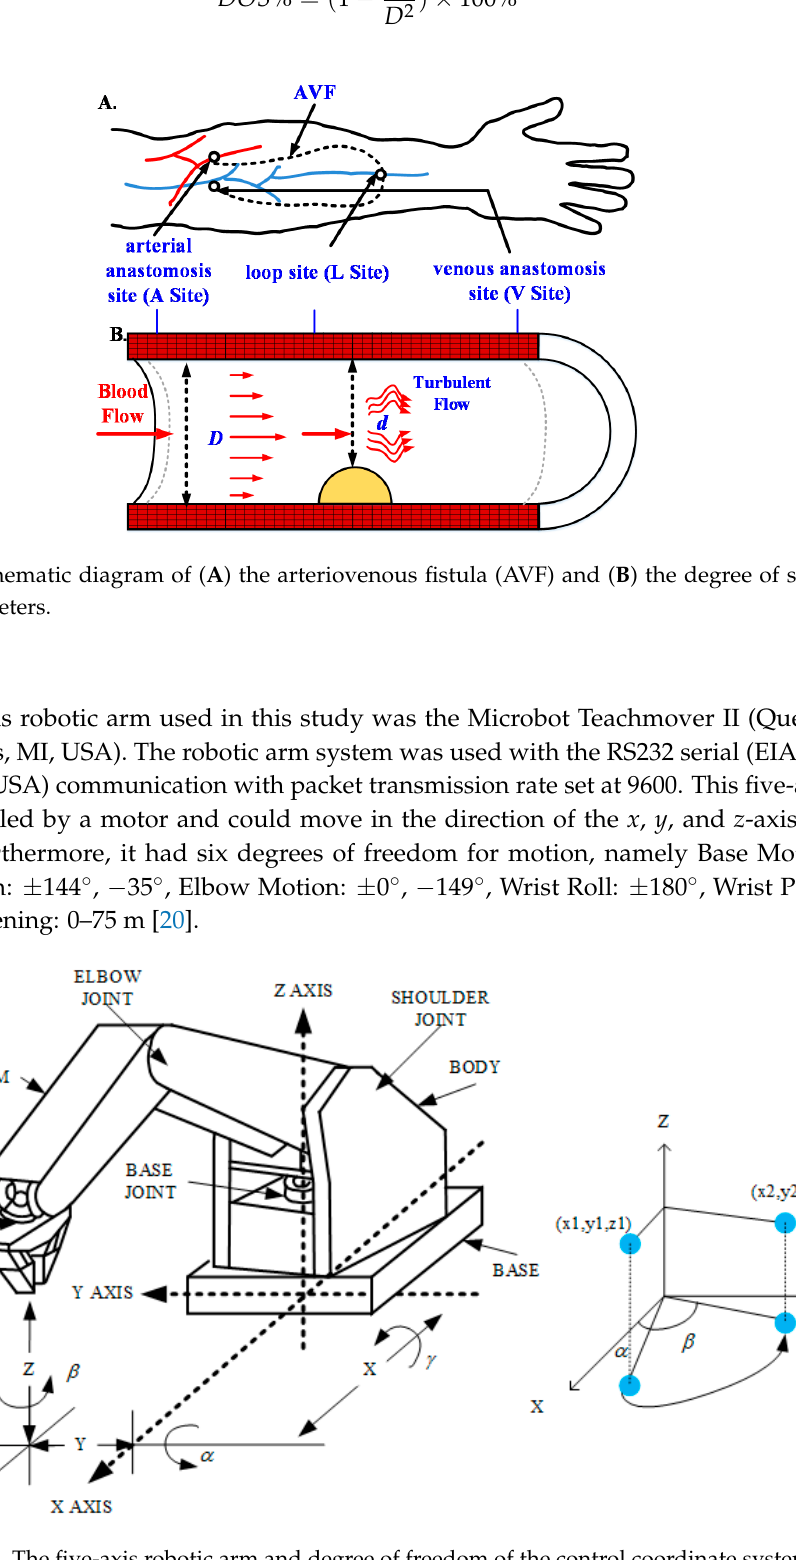
Figure 3. The five-axis robotic arm and degree of freedom of the control coordinate system.